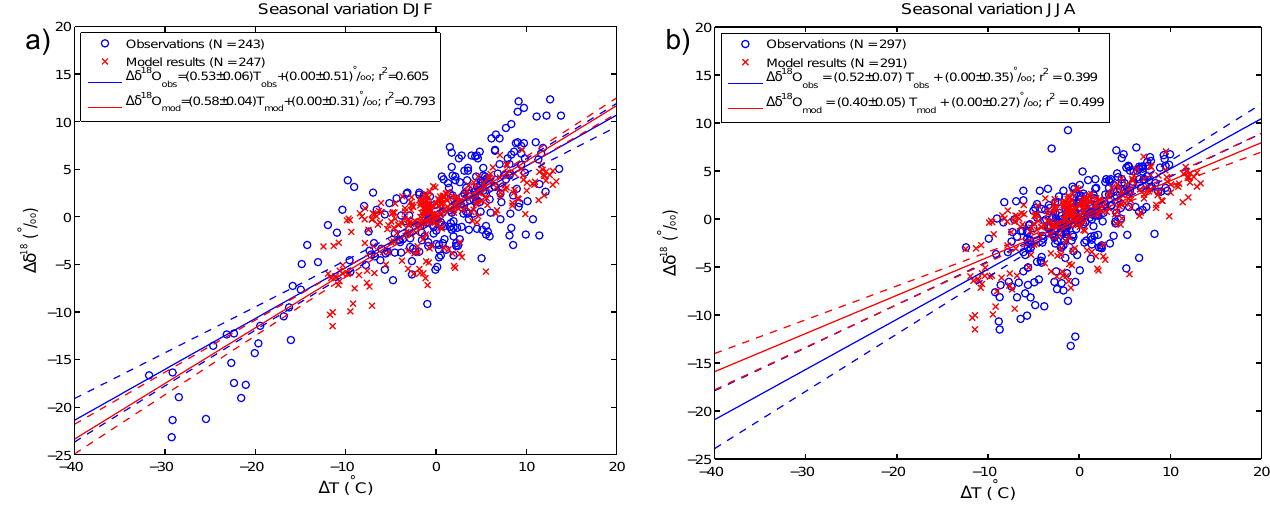
Figure 4. Relationship between δ 18 O and surface temperature. Shown are monthly anomalies ( 1δ 18 O and 1 T) according to monthly obser- vations from 15 GNIP stations in Russia (circles) and the related ECHAM5-wiso model results (crosses), (a) winter season and (b) summer season. Solid lines are obtained from a least-squares linear fit of observations and model results; dashed lines indicate 95% confidence intervals for the fits. Table 2. Linear trend estimates and 95% confidence intervals for annual and seasonal surface temperature, precipitation, and δ 18 O in precipitation simulated for the period